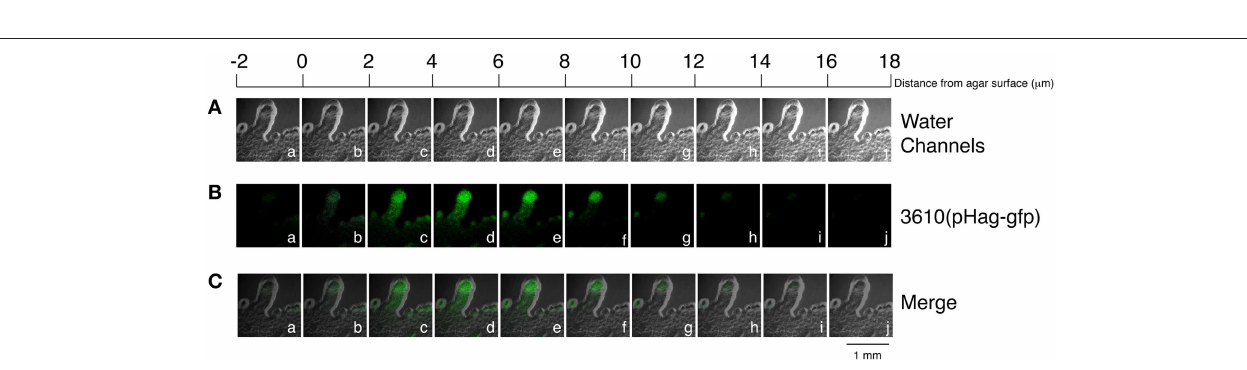
using 3610(pSrf-gfp) on 25-ml LB-0.7 agar. We found